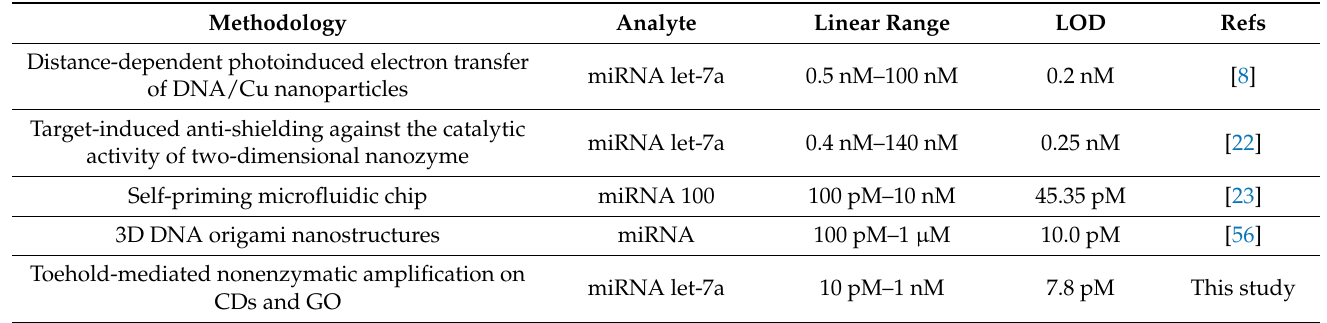
Table 2. Comparison with previously developed sensors for miRNA Table 2 . Comparison with previously developed sensors for miRNA detection.